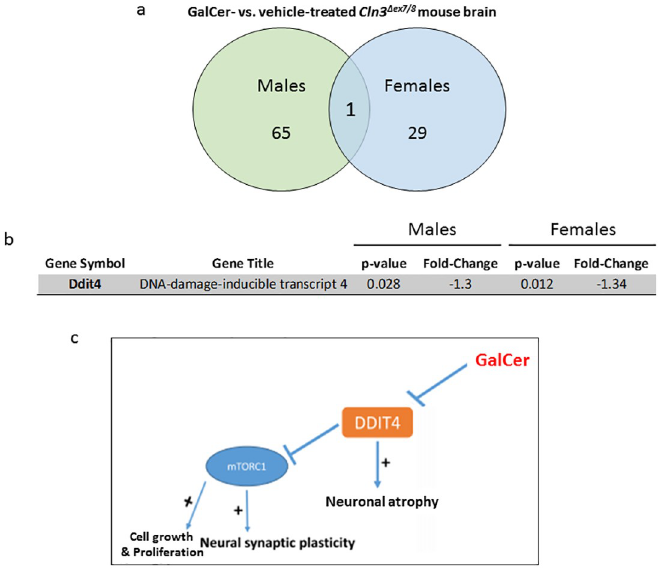
Fig 9. Comparative analysis of DEGs in male and female Cln3 Δ ex7/8 mouse brain. Depiction of DEGs selected in male and female Cln3 Δ ex7/8 mouse brain based on gene expression in GalCer compared to vehicle-treated Cln3 Δ ex7/8 mice of both genders. The criterion for differential expression was a p-value < 0.05, and a stringency � ± 1.3-fold change in expression. (a) A total number of 96 genes, with 65 and 29 genes exclusive for male and female Cln3 Δ ex7/8 mouse brain, respectively, shown. One gene appears in the overlapping region, common to both datasets. (b) Fold change and p-value of the gene ( Ddit4 ) common to male and female datasets. (c) Schematic representation of the effect of GalCer on the function of Ddit4 in